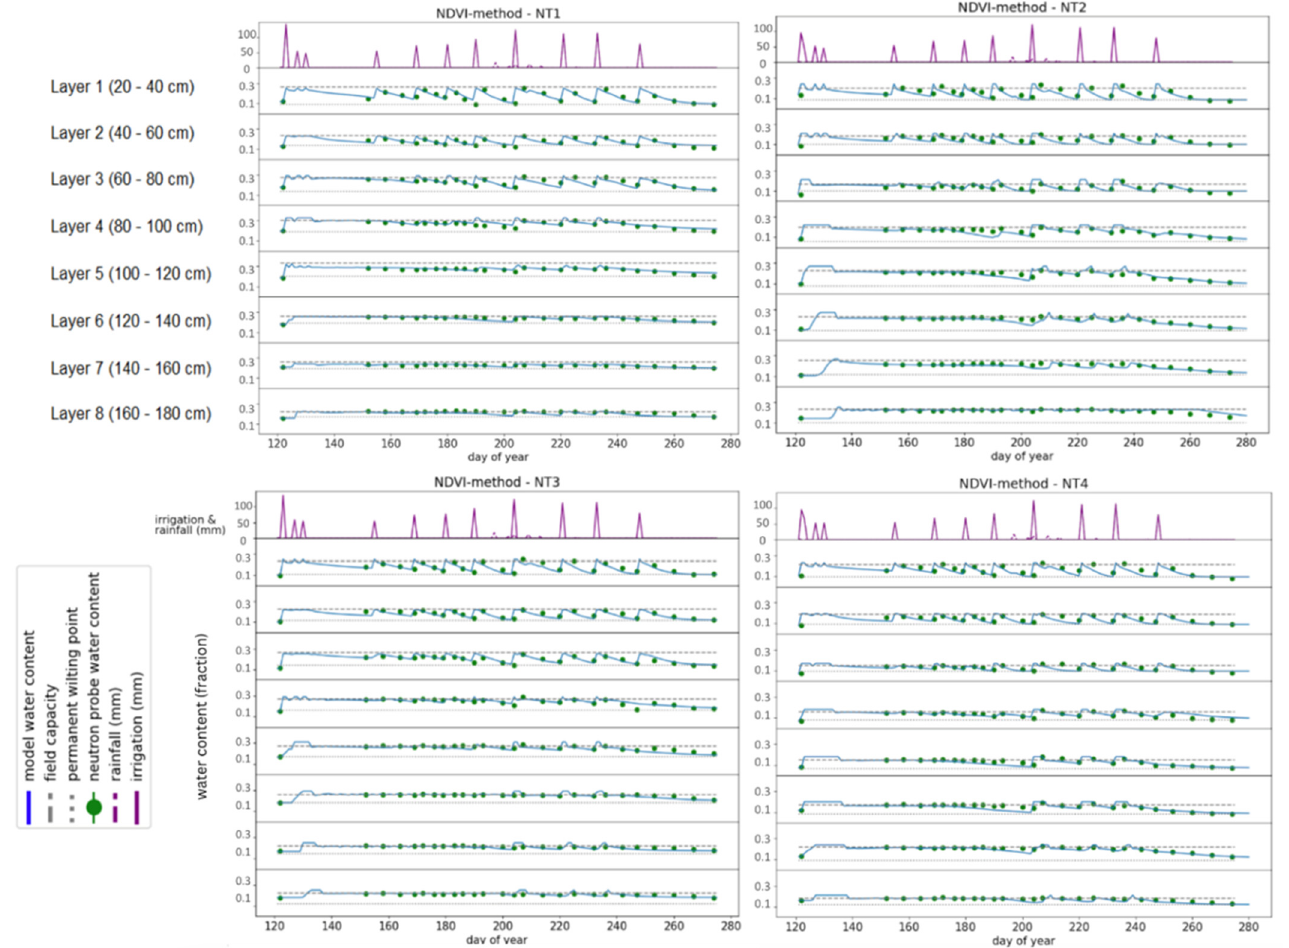
Figure 6. Daily simulated water content vs. neutron moisture meter measurements for the NDVI K cb method.